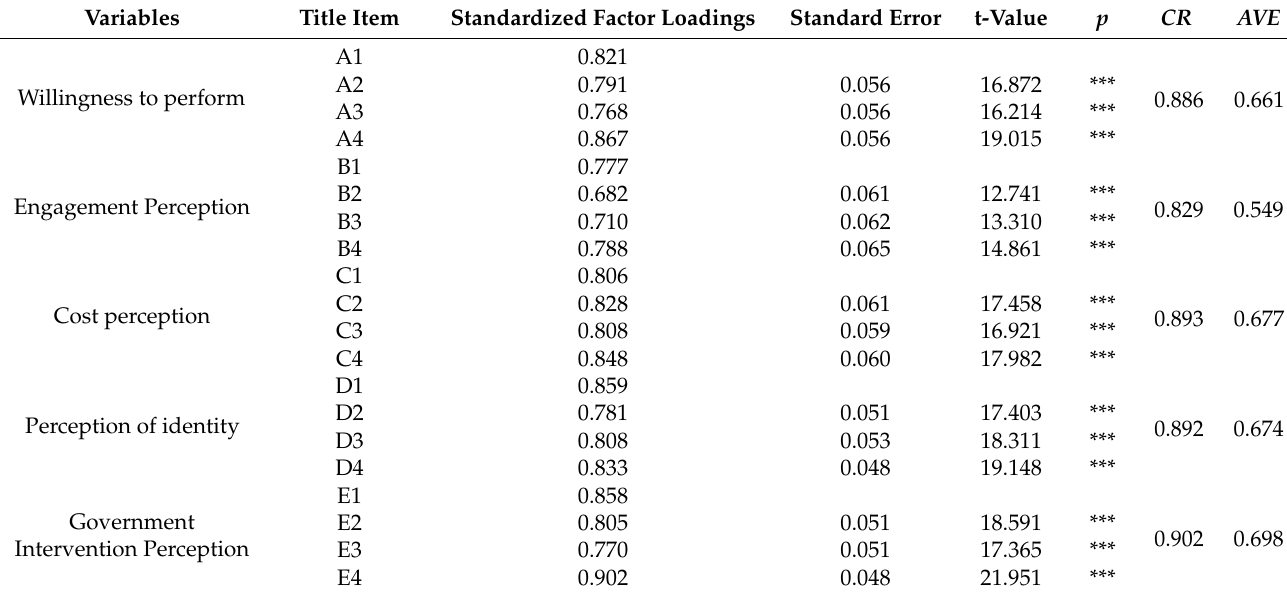
Table 9. Results of convergent validity analysis.